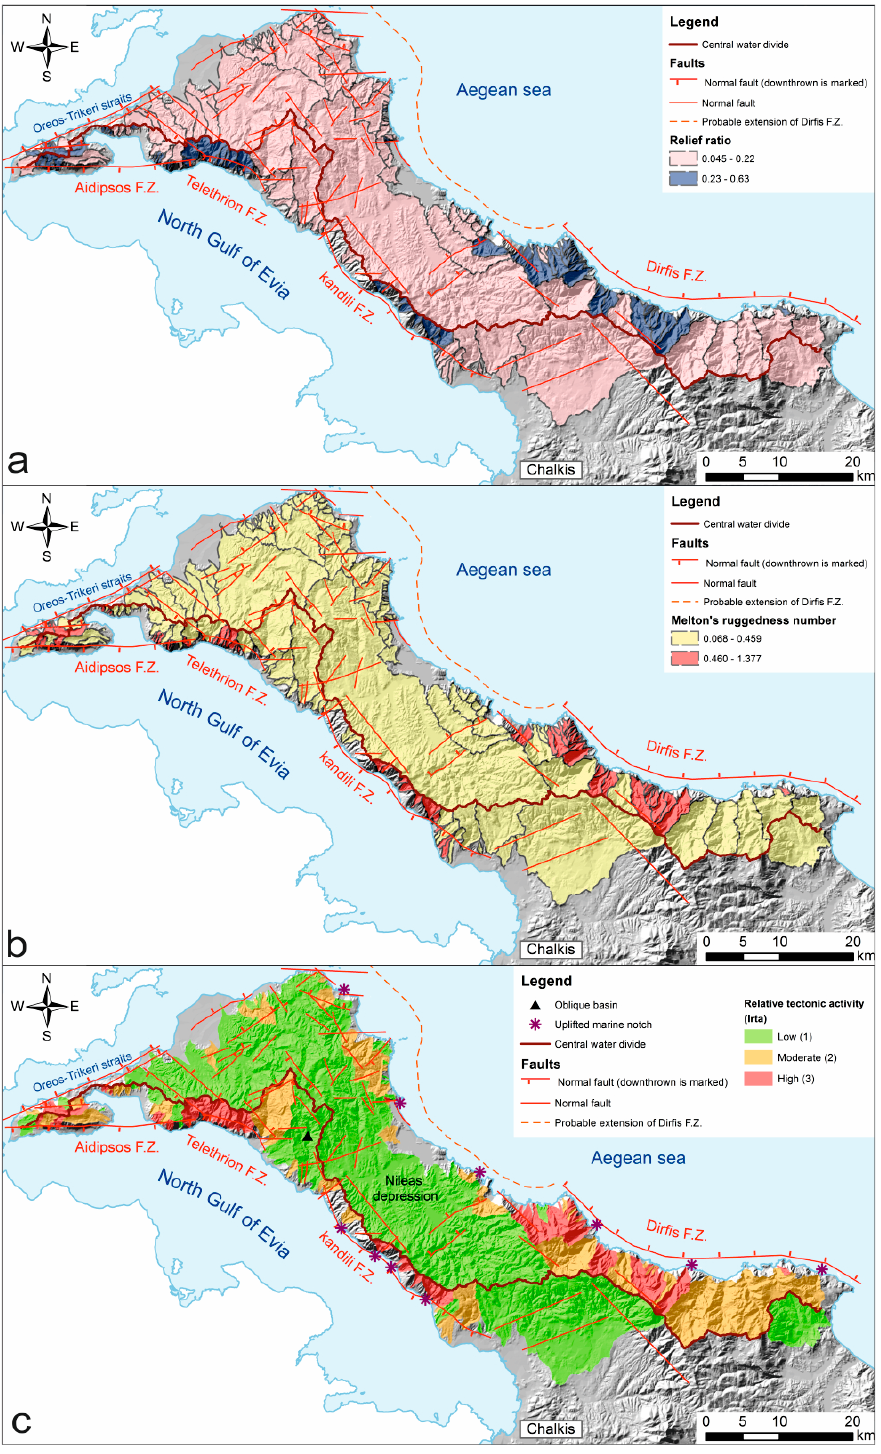
Figure 4. Spatial distribution of ( a ) Relief Ratio (R h ), ( b ) Melton's Ruggedness Number (M), and ( c ) the proposed integrated index Irta, which takes into account the above five morphometric parameters and divides the landscape into three classes of relative tectonic activity; sites of uplifted marine notches (asterisks) are based on Stiros et al. [37].